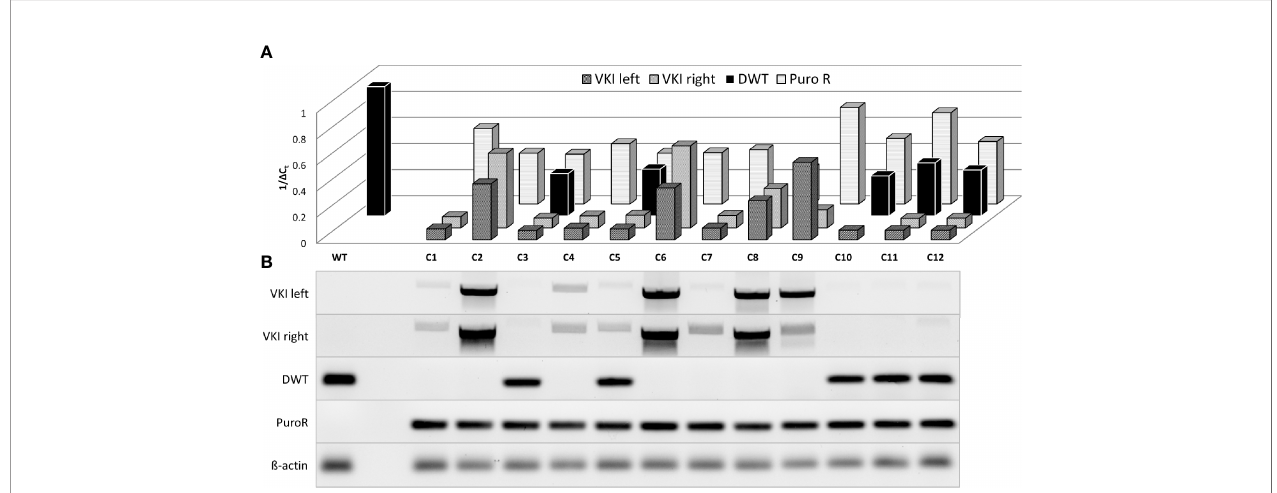
FIGURE 4 | Semiquantitative analysis of genomic changes in dual target-selected, double positive ASC clones. ASCs were transfected with both pDonor and pgRNA-Cas9 (pD+gRNA2/3). 14 days p.T. twelve BFP-, EGFP+, dT+ clones were selected and separately cultured upon reaching enough cells for genomic analysis. (A) Real Time Quantitative PCR of sequences associated with HDR was carried out analogously to population analysis. (B) Agarose gel electrophoresis of